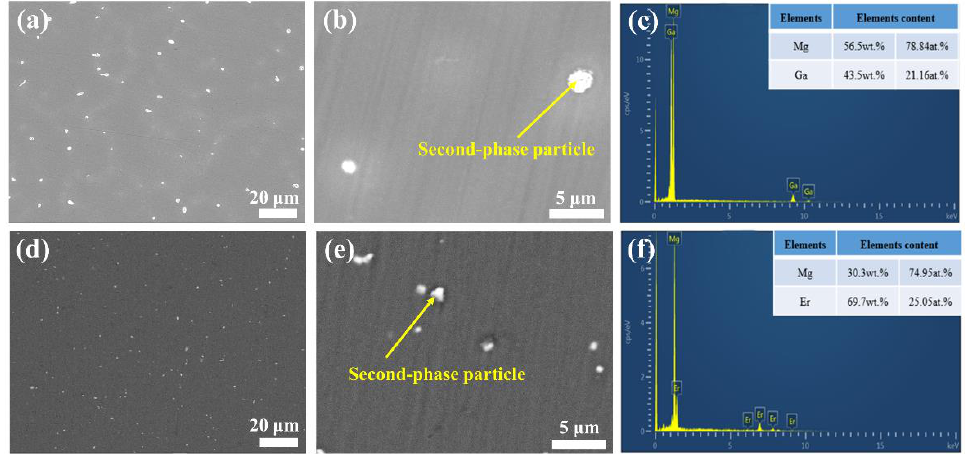
Figure 3. ( a , b ) SEM images of as-cast Mg-Ga alloy; ( c ) the corresponding EDS result of as-cast Mg-Ga alloy; ( d , e ) SEM images of as-cast Mg-Er alloy; ( f ) the corresponding EDS result of as-cast Mg-Er alloy.